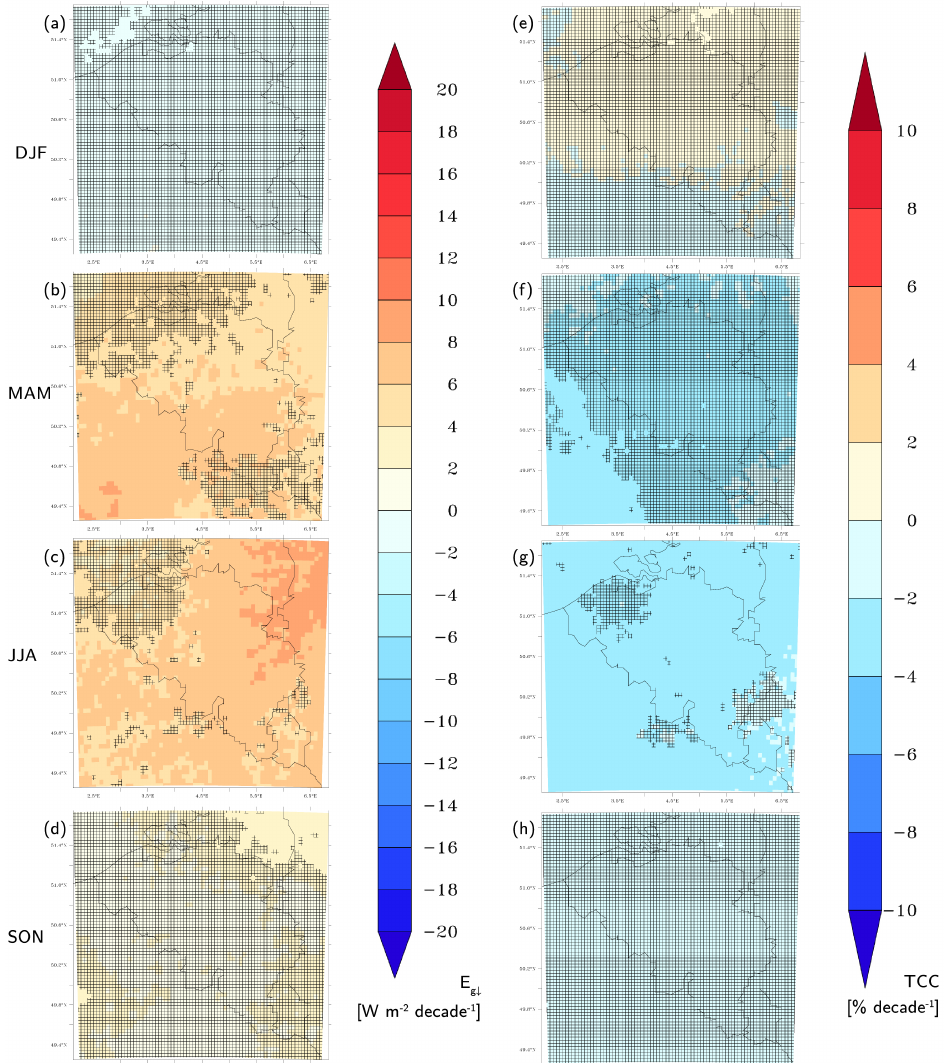
Figure 8. Seasonal trends in ( a – d ) E g ↓ and ( e – h ) TCC computed from the MAR-ERA outputs for 1980–2010 (brightening period). Filled pixels indicate the places where the trends are statistically significant at the 95% confidence level. Hashed pixels indicate the places where the trends are statistically